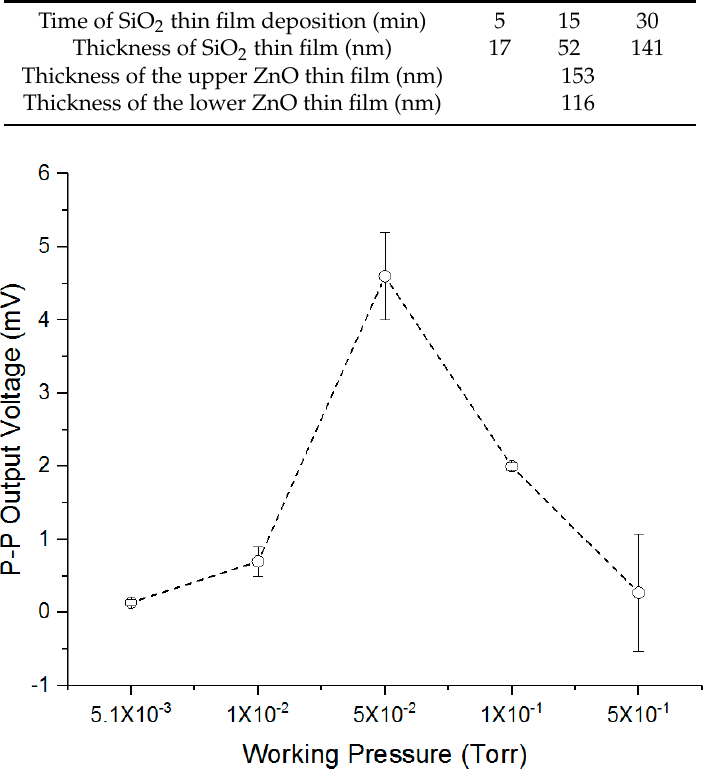
Figure 8. Peak to peak (P–P) output voltage variations of various ZSZ-MGs with different SiO 2 thin films deposited under different working pressures. Deposition power is fixed at 200 W.